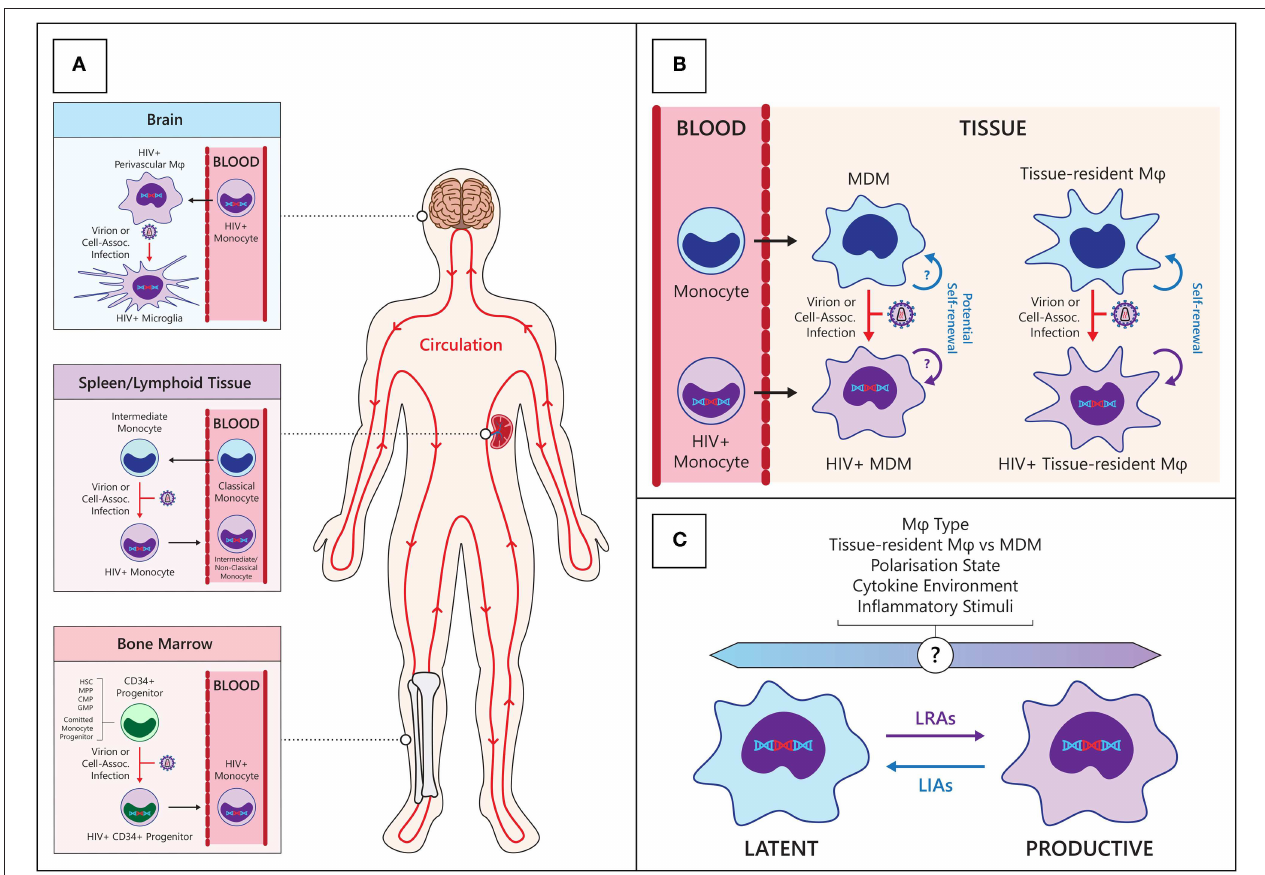
FIGURE 1 | Establishment and maintenance of the HIV myeloid reservoir. (A) CD34 + progenitors—hematopoietic stem cells (HSC), multipotent progenitor (MPP), committed myeloid progenitors (CMP), granulo-monocyte progenitors (GMP), and committed monocyte progenitors—in the bone marrow may become infected with HIV then migrate and differentiate into monocytes in circulation (Bottom panel). Classical monocytes differentiate into intermediate monocytes and migrate into tissues such as the spleen, where they may become infected with HIV and re-enter the circulation (center panel). Circulating HIV-infected monocytes can enter anatomical sanctuary sites such as the brain, differentiate into macrophages ( φ ) and thus seed tissue reservoirs (Top panel). (B) HIV macrophage reservoirs in tissues can be maintained by infiltrating infected monocytes, de novo infection of monocyte-derived macrophages (MDM) within tissues, and by homeostatic self-renewal of infected tissue-resident macrophages. (C) Various endogenous and exogenous factors may influence the state of HIV infection within macrophages. LRAs, latency reversing agents; LIAs, latency inducing